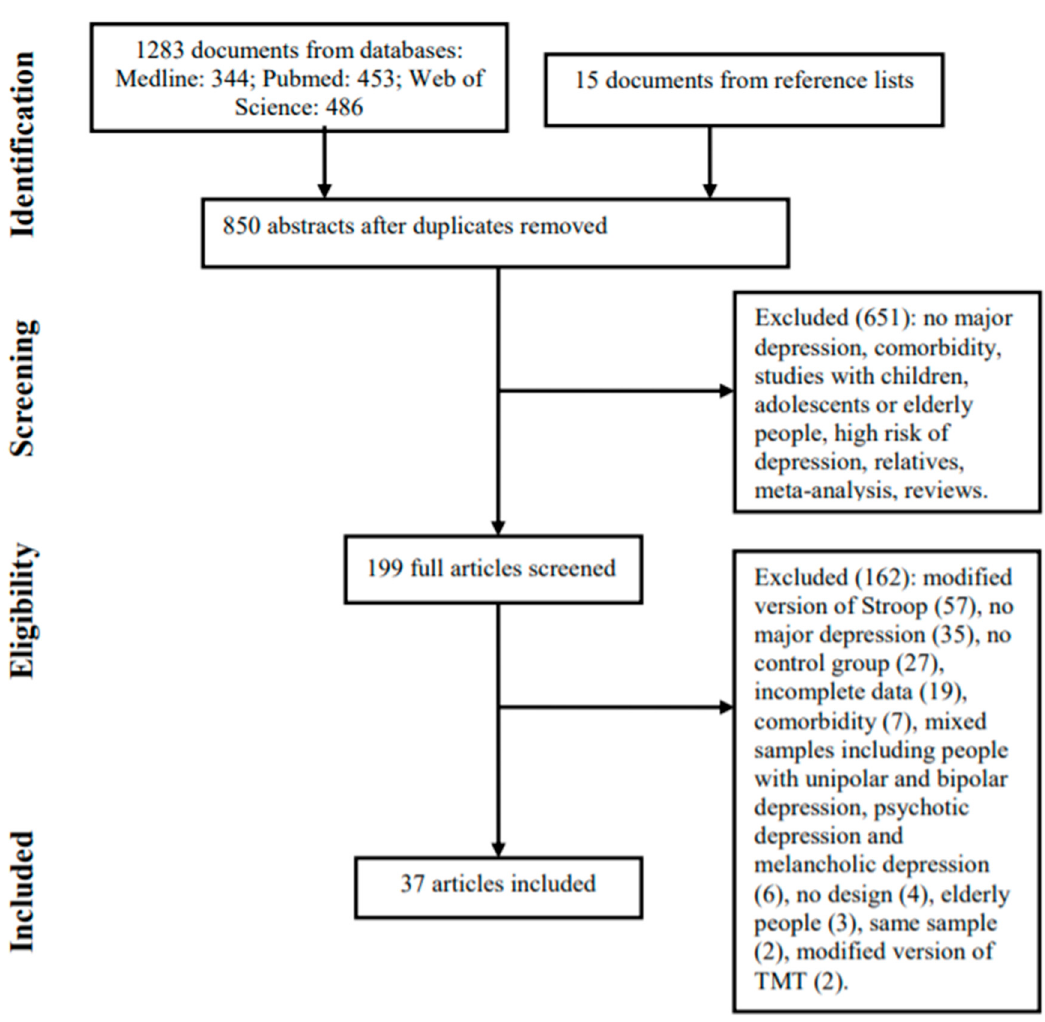
Figure 1. Selection process for study inclusion.